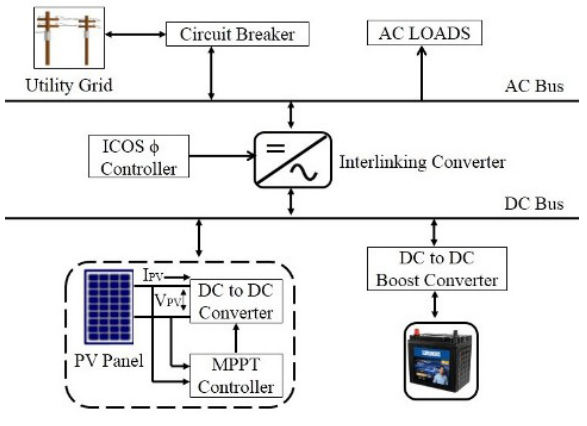
Fig. 1. Schematic Diagram of test